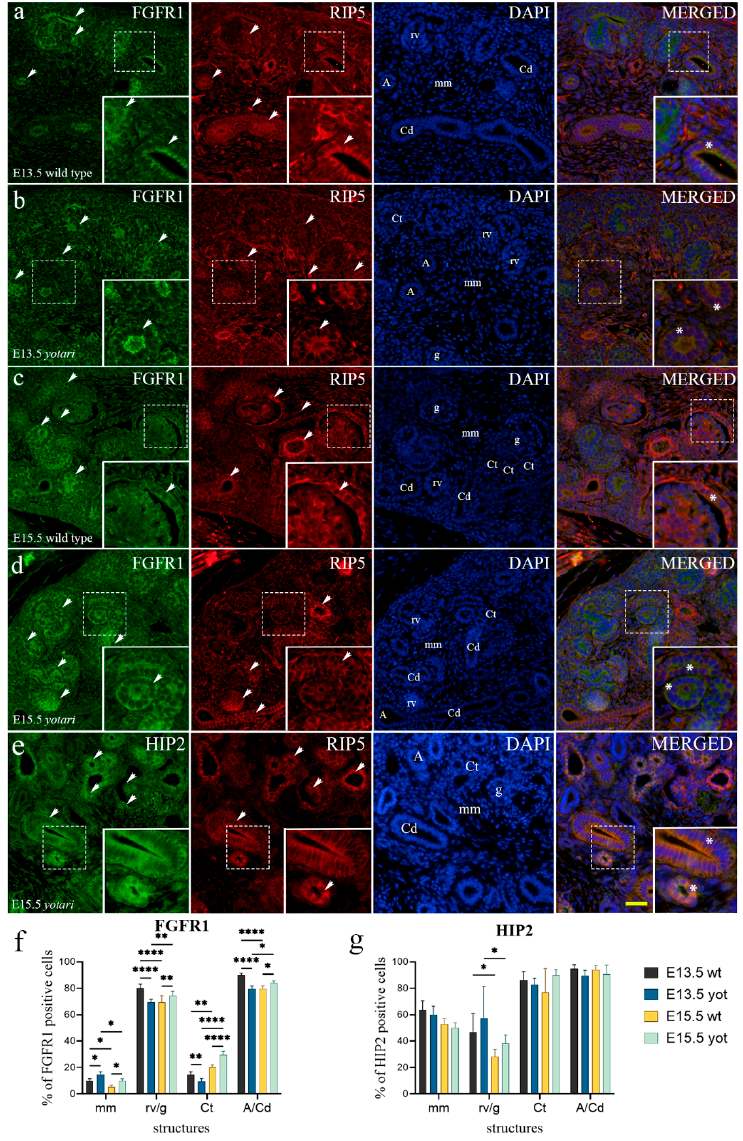
Figure 1. Double immunofluorescence staining of embryonic wild-type and yotari mouse kidneys with the FGFR1 ( a – d ), HIP2 ( e ), and RIP5 markers ( a – e ). Arrows show the expression pattern of FGFR1, HIP2, and RIP5 in metanephric mesenchyme (mm), renal vesicles (rv), glomeruli (g), convoluted tubules (Ct), ampullae (A), and collecting ducts (Cd) indicated on 4 ′ ,6-diamidino-2- phenylindole (DAPI) image. Immunoexpression of FGFR1, RIP5, DAPI staining and merged FGFR1, RIP5, and DAPI at embryonic days E13.5 and E15.5 in wild type ( a , c ) and yotari ( b , d ). Immunoexpression of HIP2, RIP5, DAPI staining and merged HIP2, RIP5, and DAPI at E15.5 in yotari ( e ). Wild-type and yotari mice at E13.5 of kidney development mostly correspond regarding localization and intensity of HIP2; thus, a representative image was selected from E15.5. The most prominent protein expression area is shown in inserts, corresponding to the dashed boxes. An asterisk denotes the zone where co-expression was detected. Images were taken on magnification × 40. The scale bar is 50 µ m, which refers to all images. The distribution of the percentages of FGFR1 ( f ), and HIP2 ( g ) positive cells in the metanephric mesenchyme (mm), renal vesicles (rv) or glomeruli (g), convoluted tubules (Ct), and ampulla (A) or collecting ducts (Cd) of wild type and yotari kidneys at embryonic days E13.5 and E15.5. Data are presented as the mean ± SD (vertical line) and analyzed by a two-way ANOVA test followed by Tukey’s multiple comparison test. Significant differences were indicated by * p < 0.05, ** p < 0.001, **** p < 0.00001. At each time point, ten substructures were